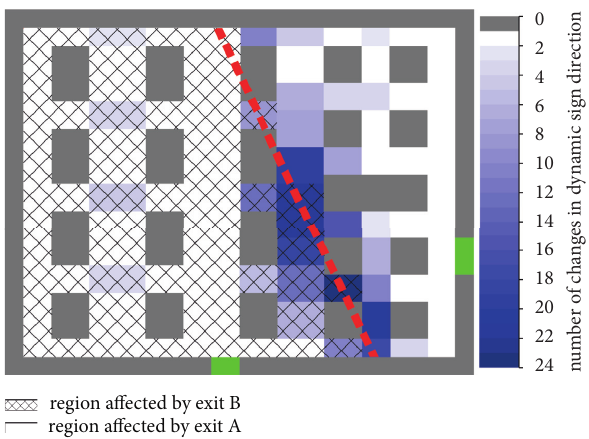
Figure 7: The change times of dynamic sign direction in the grids. Table 3: : Experimental scheme for different evacuation sign guidance. Experiment